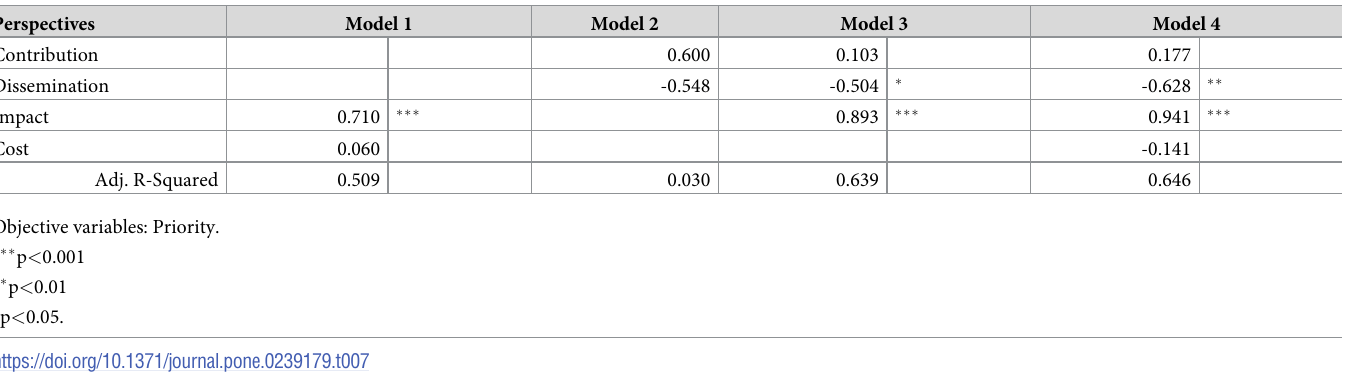
Table 7. The influence of contribution, dissemination, impact, and cost on priority (standardized